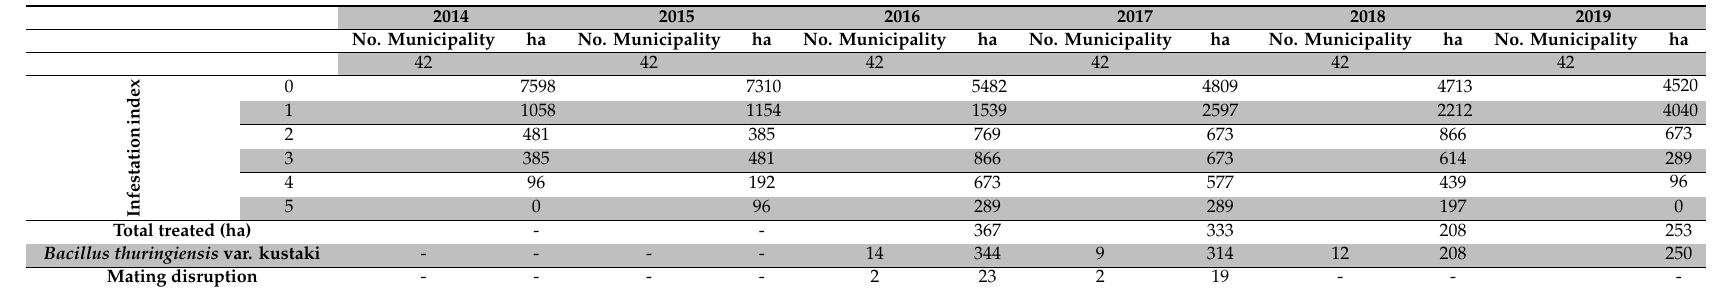
Table 1. Infestation index recorded, and the total area (ha) treated with Bacillus thuringiensis var. kurstaki , and mating disruption in